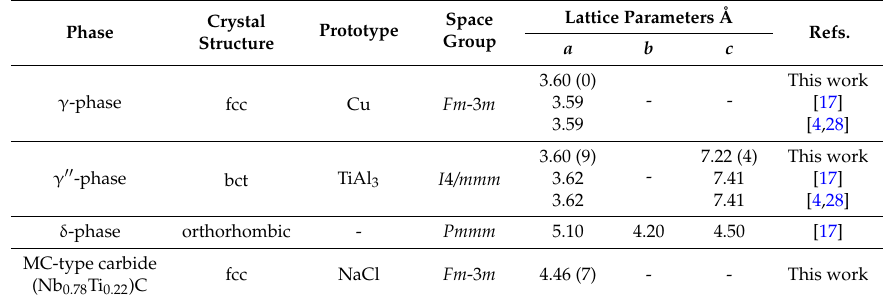
Table 4. Identification and crystallographic data of the detected phases in the current study.